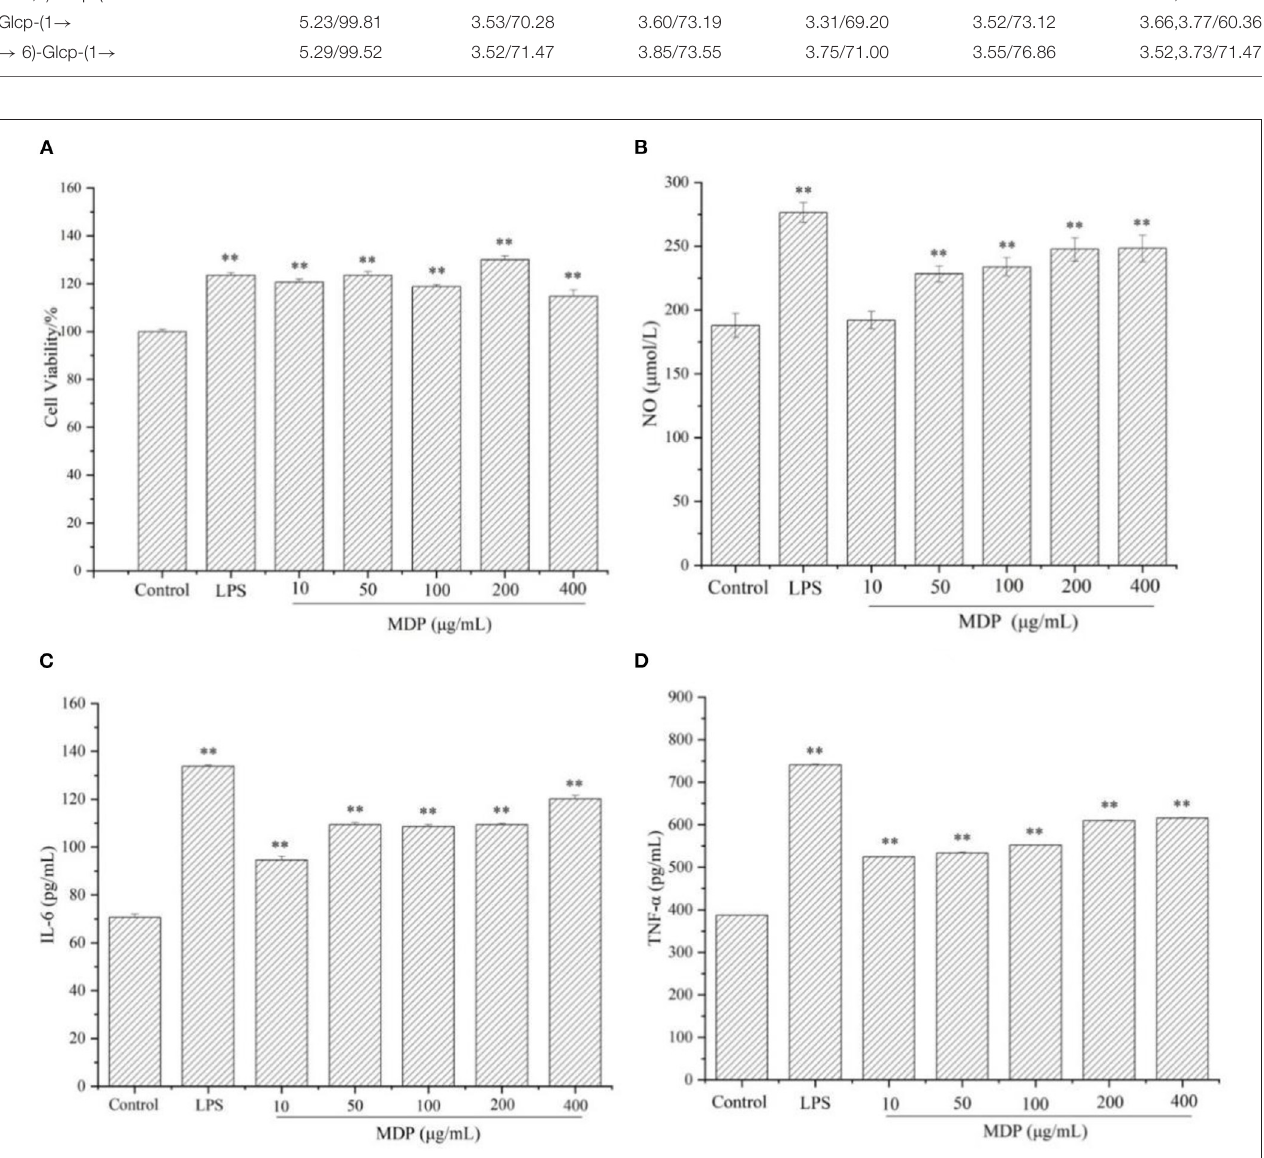
FIGURE 5 | The immunological activities of MDP in vitro . (A) Effects of MDP on the viability of RAW264.7 cells. (B) Effect of MDP on the secretion of NO in RAW264.7 cells. (C) Effect of MDP on the secretion of the cytokine IL-6 in RAW264.7 cells. (D) Effect of MDP on the secretion of the cytokine TNF- α in RAW264.7 cells. The values are presented as the mean SD, n 3. ** P < 0.01 vs. control group. ± =